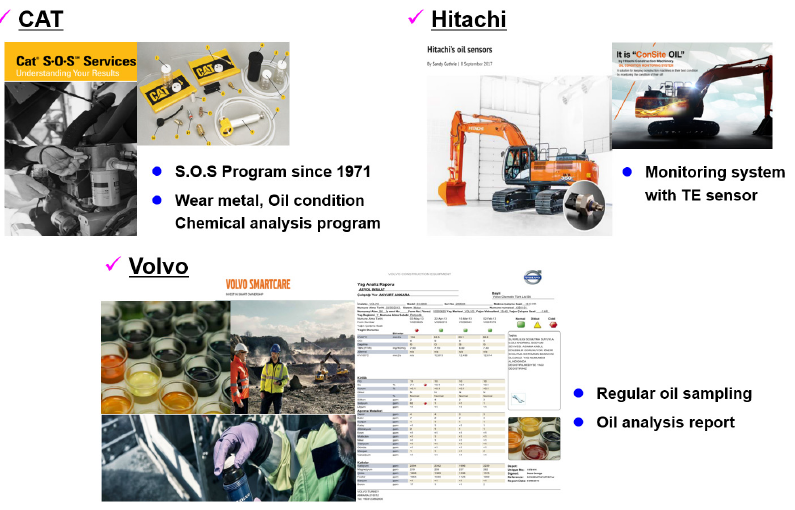
Figure 1. Oil analysis service of construction equipment company.